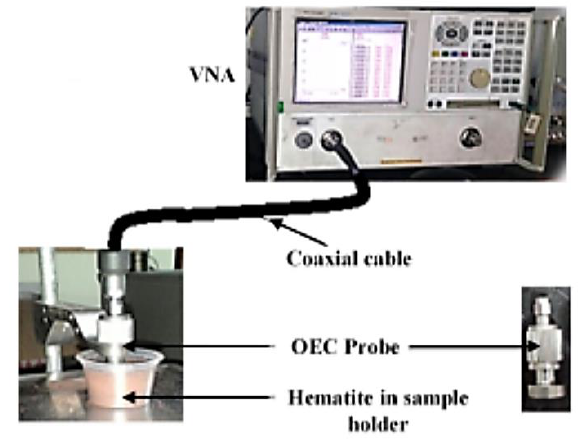
Figure 2. Measurement of complex permittivity using OEC technique.